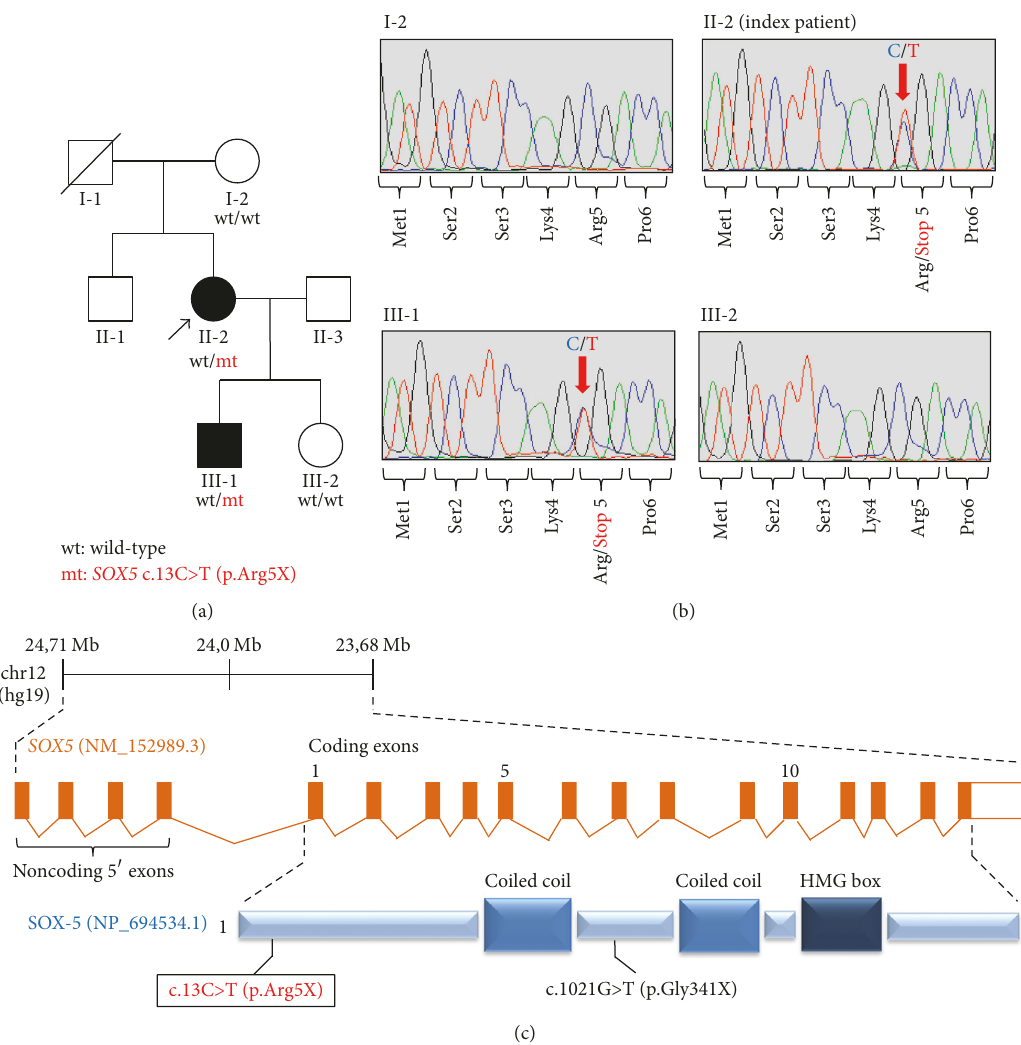
Figure 1: Loss-of-function short coding mutations in SOX5 . (a) Pedigree of the family investigated in this study. SOX5 mutational status is shown below each tested family member. Symbols are as follows: circles, females; squares, males; filled, phenotypically abnormal; empty, healthy; slash, deceased. (b) Dideoxy sequencing traces document SOX5 c.13C > T (p.Arg5X) in genomic DNA of the index patient II-2 and her son III-1. Individuals I-2 and III-2 show homozygous wild-type sequence at this site. Arrows indicate the mutant nucleotide positions. (c) Schematic overview of the human SOX5 locus (NM 152989.3; top) and its encoded protein (NP 694534.1; bottom) illustrates the newly identified c.13C > T (p.Arg5X) stop-gain variant (boxed) and a loss-of-function point mutation previously described [6]. Notably, all of the critical SOX-5 protein domains are distal to the p.Arg5X protein-truncation site and thus the truncated protein, if expressed, is highly unlikely to retain residual function. The schematic is simplified and not drawn to exact